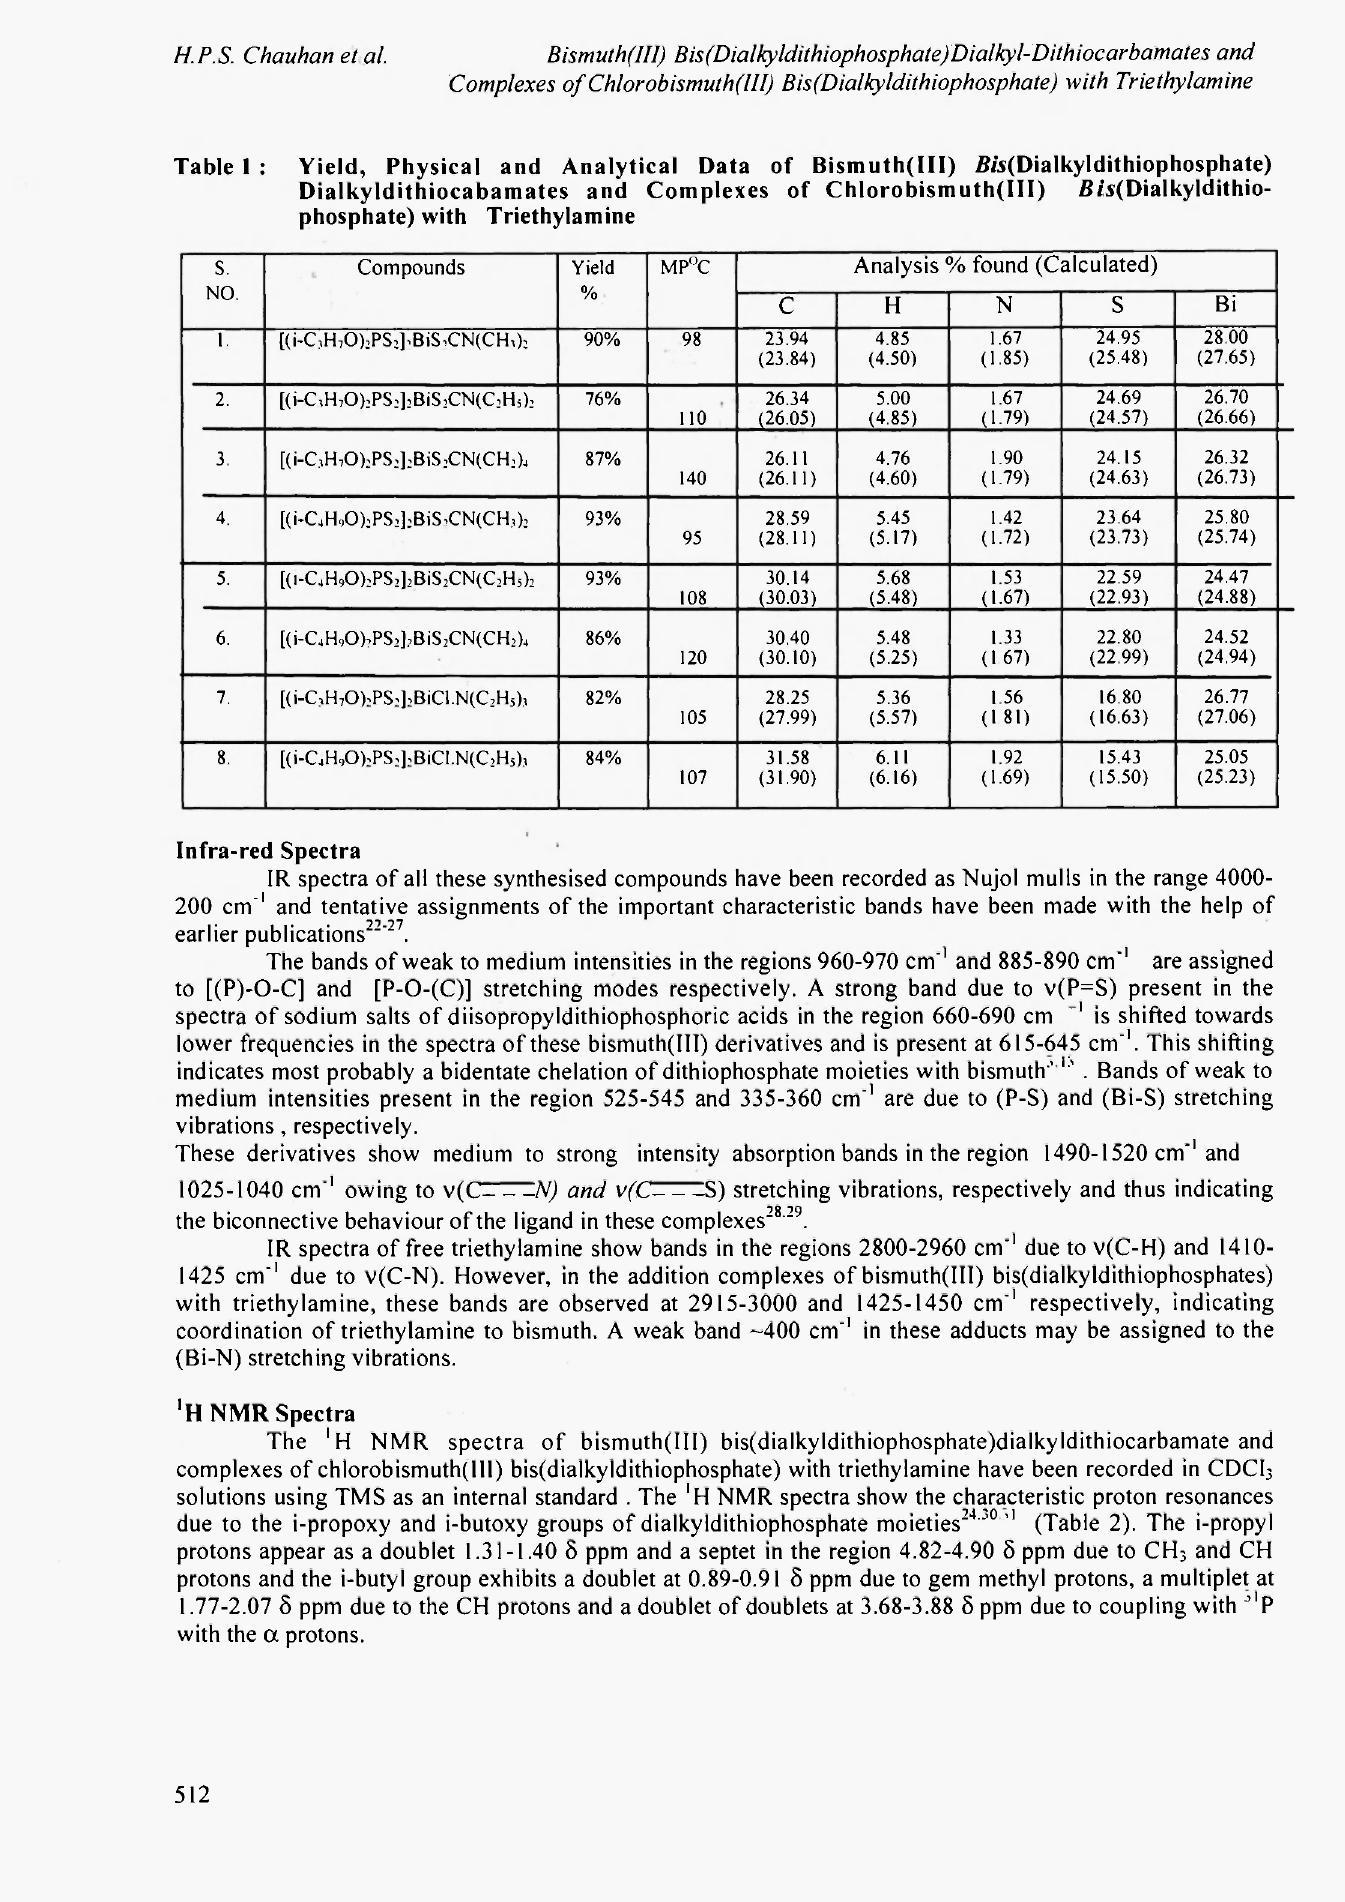
Table 1 : Yield, Physical and Analytical Data of Bismuth(UI) Ä/s(Dialkyldithiophosphate) Dialkyldithiocabamates and Complexes of Chlorobismuth(III)